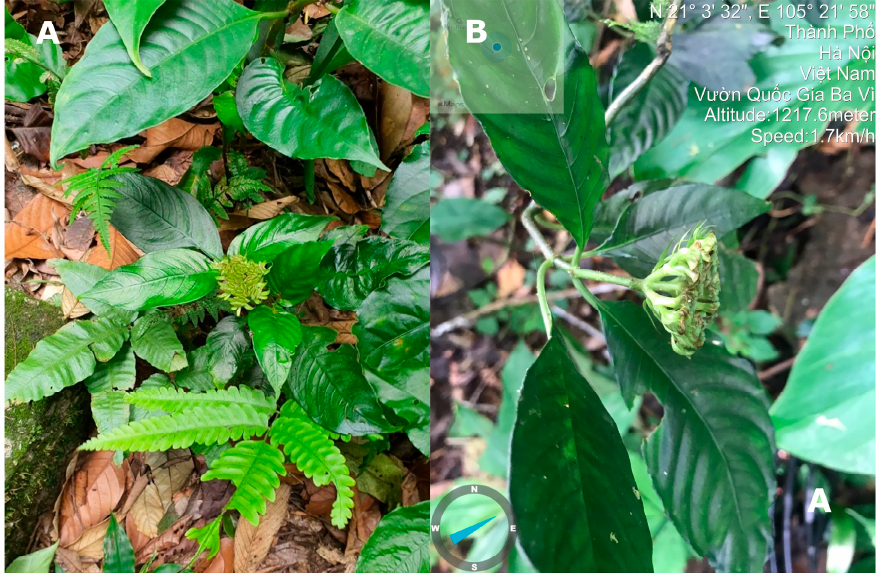
Figure 1. O. baviensis Drake. ( A ) Habitat; ( B ) Morphological characteristic of infructescence in side view; Photos by Thu Hoai